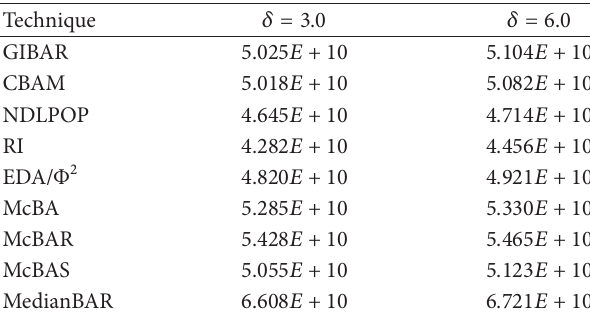
Table 8: Average execution